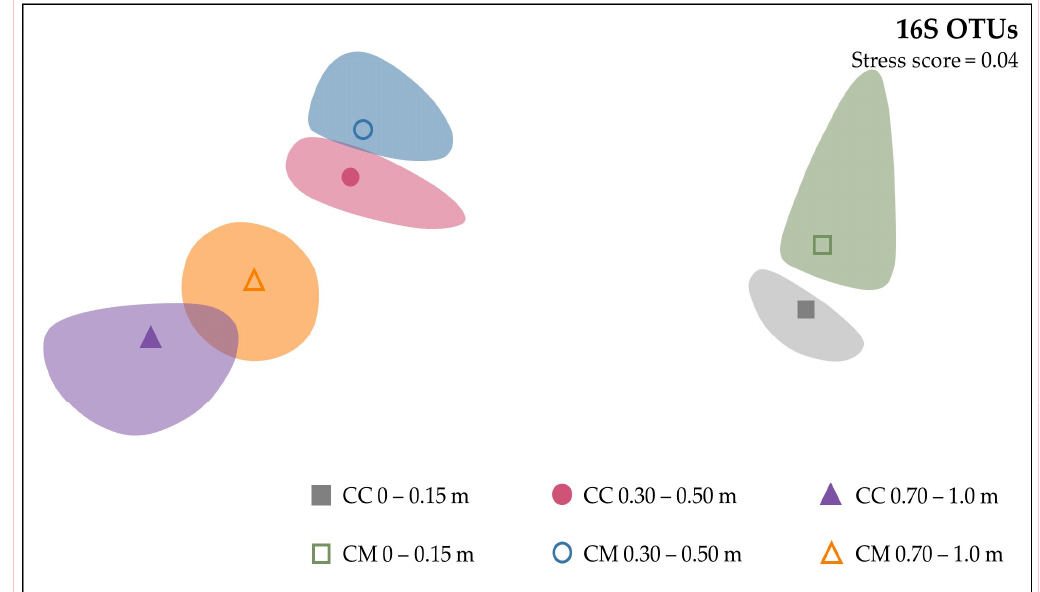
Figure 1. Dissimilarities between bacterial (16S) communities down the soil profile, as influenced by continuous cotton (CC) and cotton–maize (CM) crop systems using non-metric multidimensional scaling (nMDS) of absolute abundance OTUs based on the square root transformation of Bray–Curtis dissimilarity, with a stress score of 0.04.